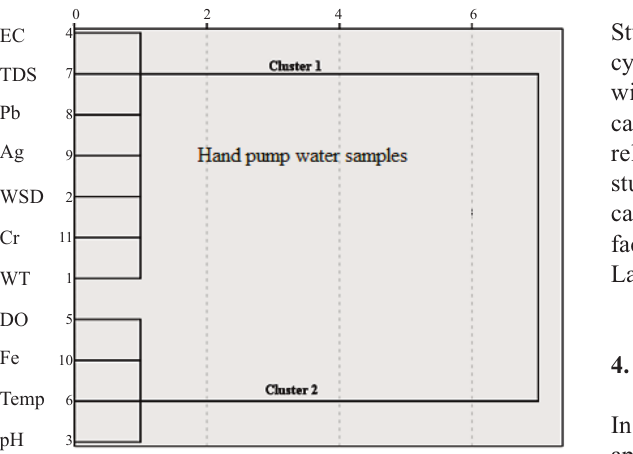
Fig. 6. HCA dendrogram of TW water